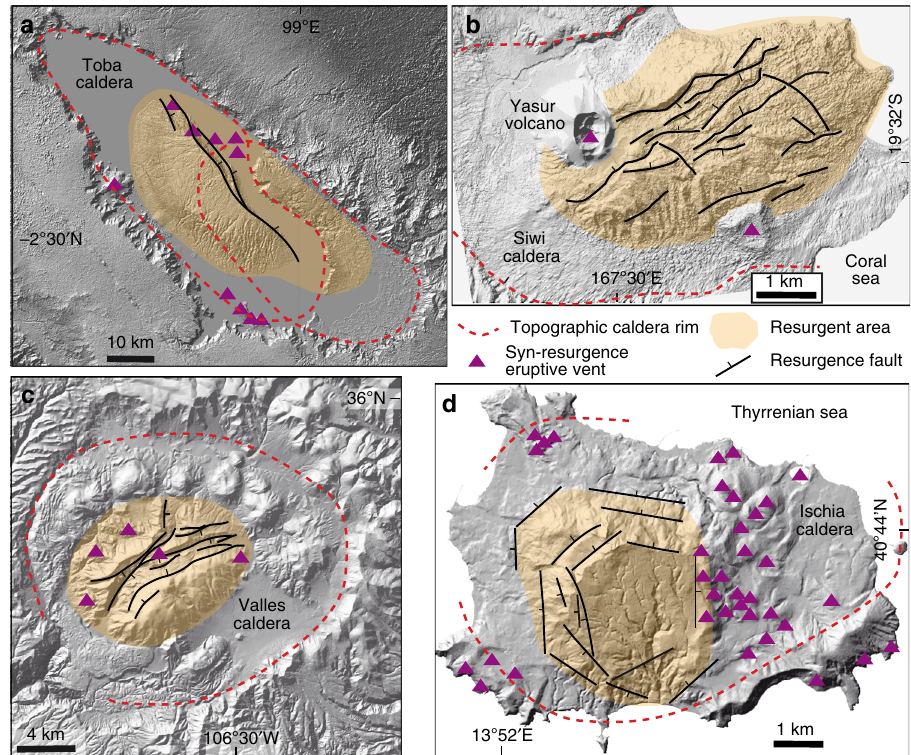
Fig. 1 Examples of resurgent calderas in nature. Representative resurgences at Toba ( a Sumatra, Indonesia), Siwi ( b Tanna, Vanuatu), Valles ( c New Mexico) and Ischia ( d Italy), highlighting the outline of the caldera, the extent of the resurgence and the location of syn-resurgence vents (including the inferred ones; see Table 1 for